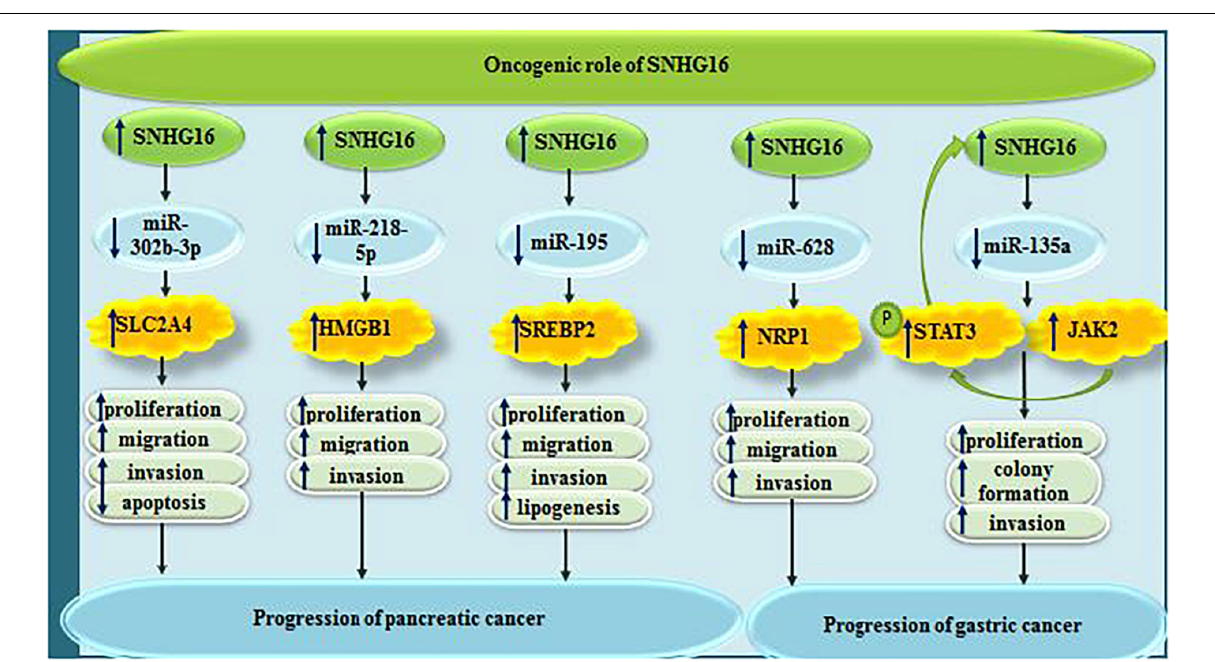
FIGURE 9 | Oncogenic roles of SNHG16 in pancreatic and gastric